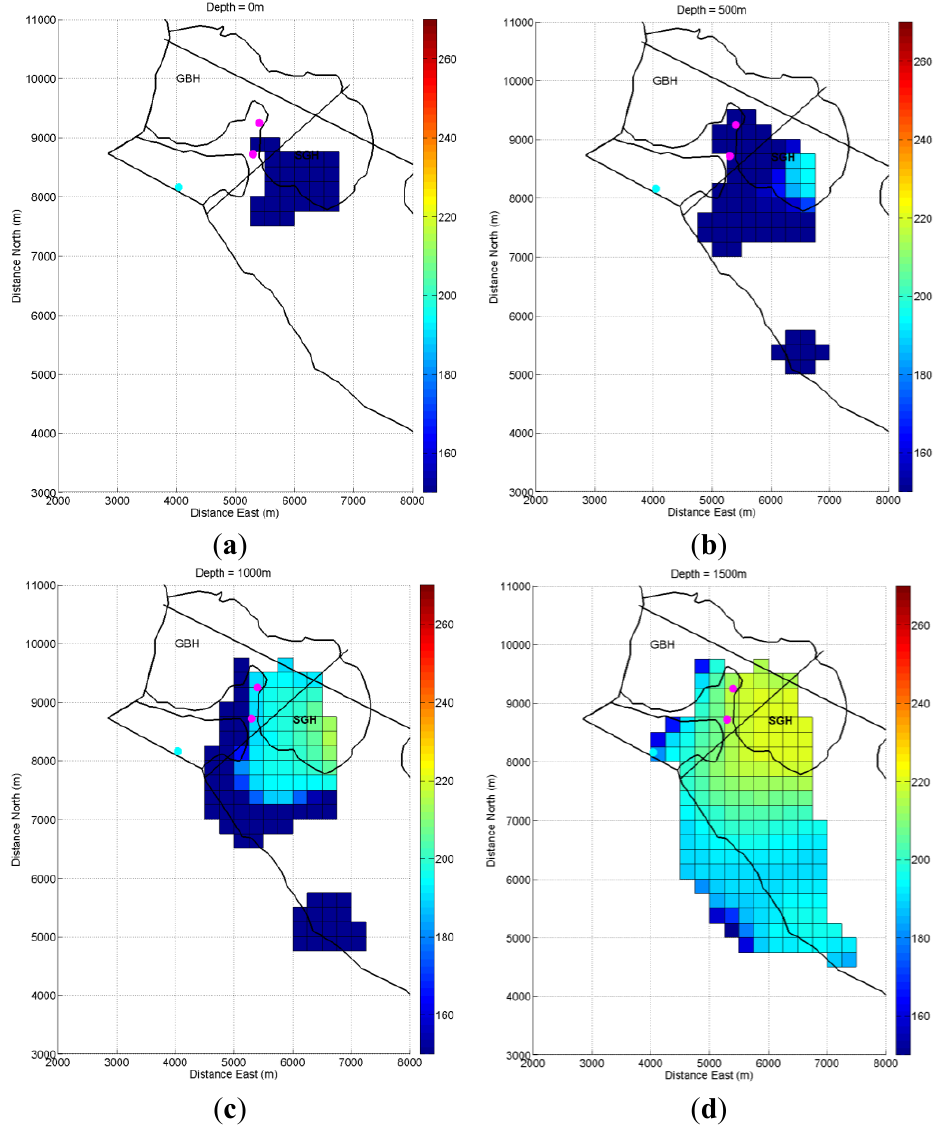
Figure 11. ( a – g ) Planar views through the SW region of the temperature model estimated from the seismic velocity anomaly data. This region corresponds to the seismic anomaly associated with the known geothermal system; ( h ) Planar view through the entire temperature model at a depth of 2000 m. Apparent temperature anomalies to the NW and NE may only be indicative of relict hydrothermal alteration in these locations or some other process altogether. The NW trending black line indicates a zone of structural weakness identified by Wadge and Isaacs [34]. The NE trending black line indicates a fault plane identified from earthquake hypocenters beneath St. George’s Hill [9]. The magenta dots relate to the locations of wells MON-1 and MON-2. The cyan dot relates to the location of the alkali-chloride hot spring at Hot Water pond. GBH (Garibaldi Hill); SGH (St. George’s Hill); GM (Gage’s Mountain); CP (Chances Peak); SHV (Soufrière Hills Volcano); RM (Roche’s Mountain); SSH (South Soufrière Hills); RE (Roche’s Estate); CH (center Hills); SH (Silver Hills). The colour scale indicates temperature in degrees